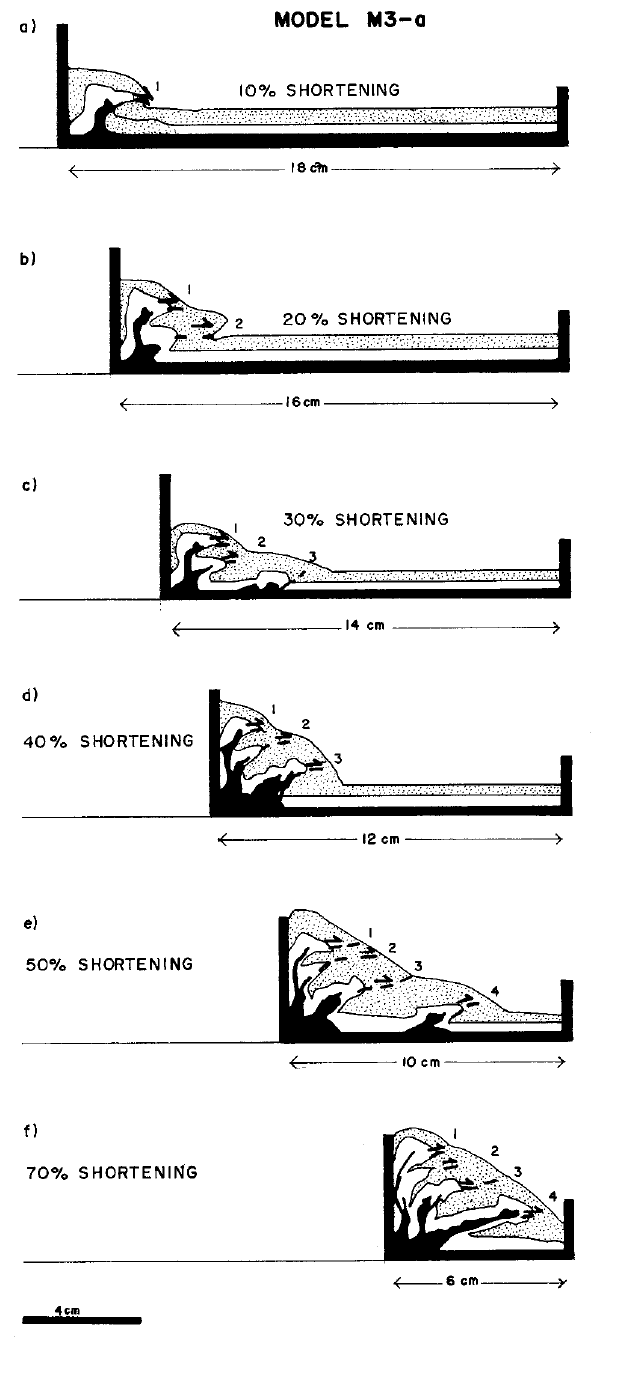
Fig. 11 – Six successive stages of model M3-a (high obstacle, initially thin sand layer and rigid backstop). This model shows strong vertical strain. After (a) 10%; (b) 20%; (c) 30%; (d) 40%; (e) 50%; and (f) 70% shortening.